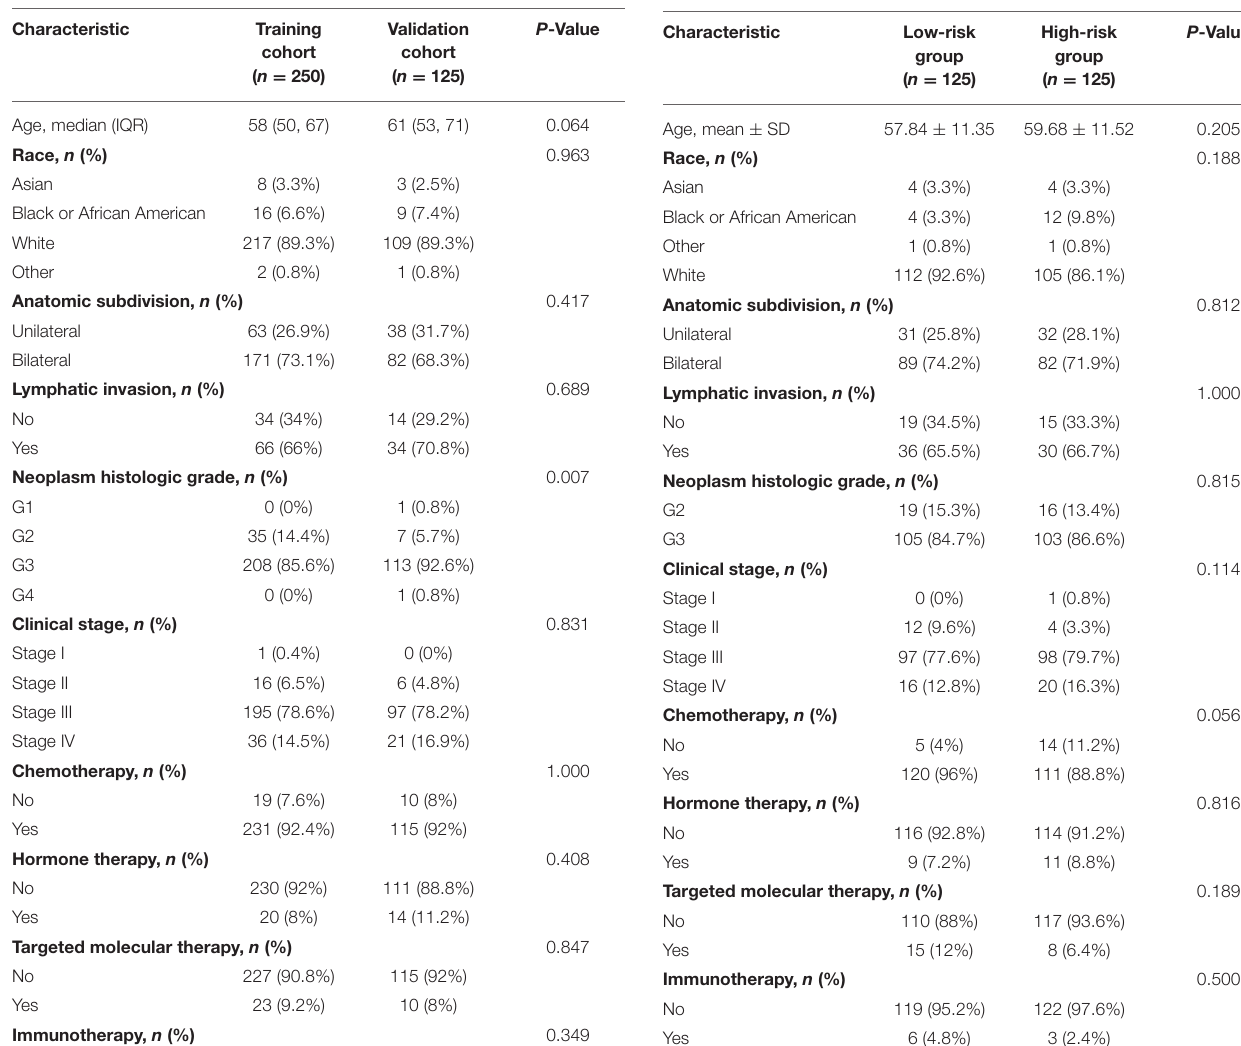
TABLE 2 | Associations between risk score and characteristics of patients with ovarian cancer in the training